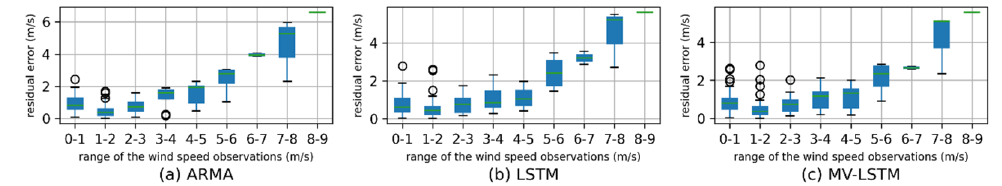
Figure 9. Boxplot of the residual errors of each method with different ranges of the wind speed on the test set of Zhaitang Station.